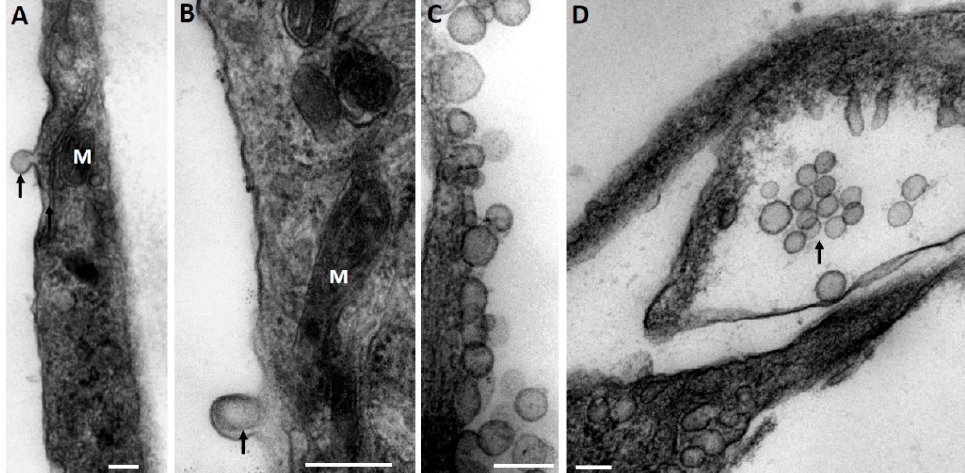
Figure 1. ( A ) Budding of the MSC cell membrane (shown by arrow) preferably in the future forming EV; ( B ) budding of the membrane with the presence of membranous structures inside (shown by arrow). Note the mitochondria (M) adjacent to the locus; ( C ) a group of vesicles adjacent to the cell membrane of the MSC; ( D ) a group of vesicles gathered in the intracellular space of the MSC. Electron microscopy. Scale, 250 nm.